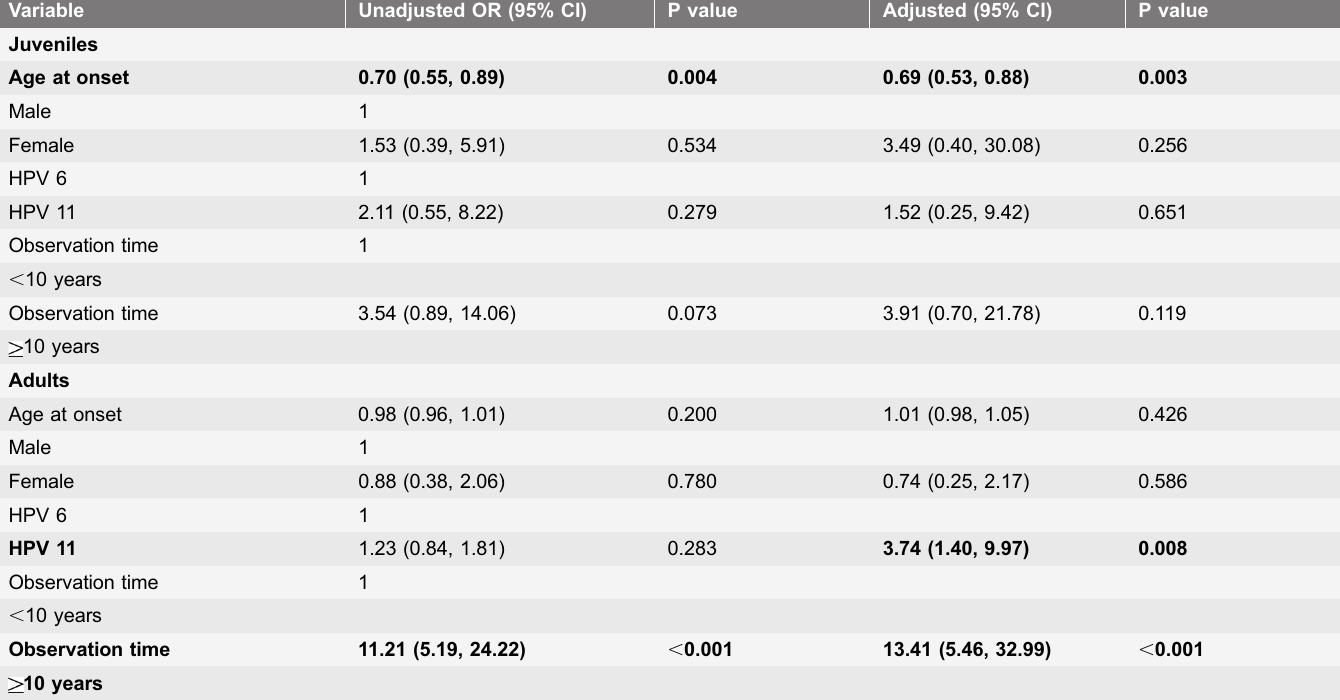
Table 6. Risk factors for an aggressive clinical course in juvenile and adult onset